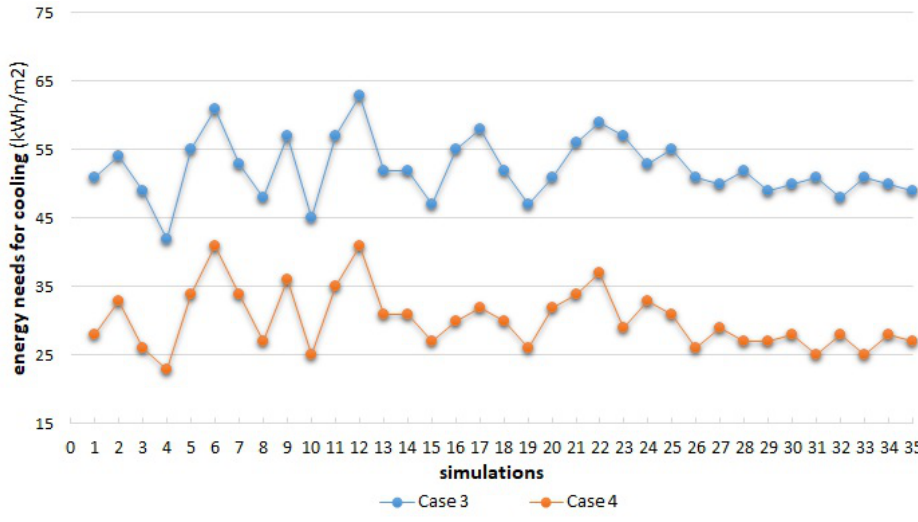
Figure 14. Energy needs for cooling in Cases 3 and